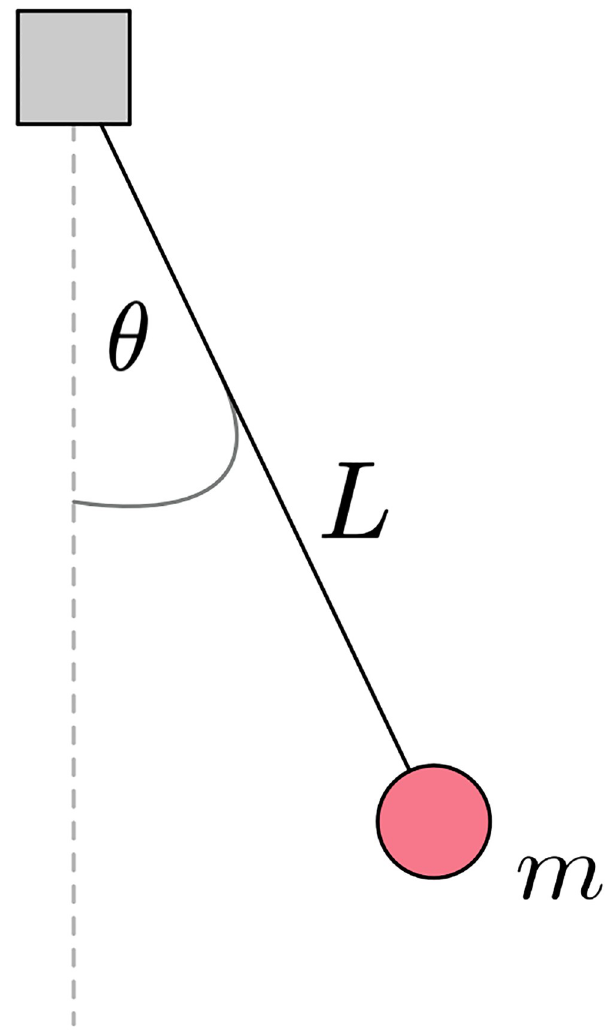
Fig 1. The controlled system is a pendulum with mass m hanging from a weightless rod of length L . The angle between the pendulum and its vertical axis is denoted by θ , where θ = 0 rad indicates the pendulum’s downward position. The goal of the task assigned to participants is to swing the pendulum in order to balance it in its upright position for as long as possible (i.e., θ ’ π rad and _ y � 1 rad s (cid:0) 1 ).